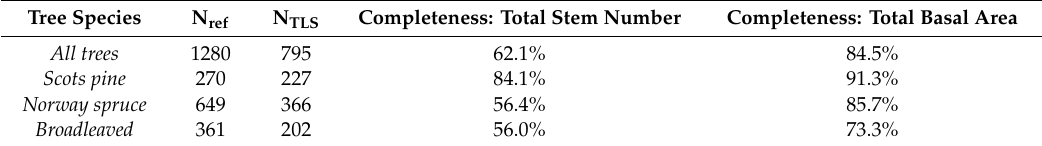
Table 3. The number of trees by tree species that were measured in the field (N ref ) and detected from the TLS point clouds (N TLS ) at the beginning (2014) and at the end of the monitoring period (2019). Completeness indicates how large a part of the detected trees represented the total number and the total basal area of the field measured trees.